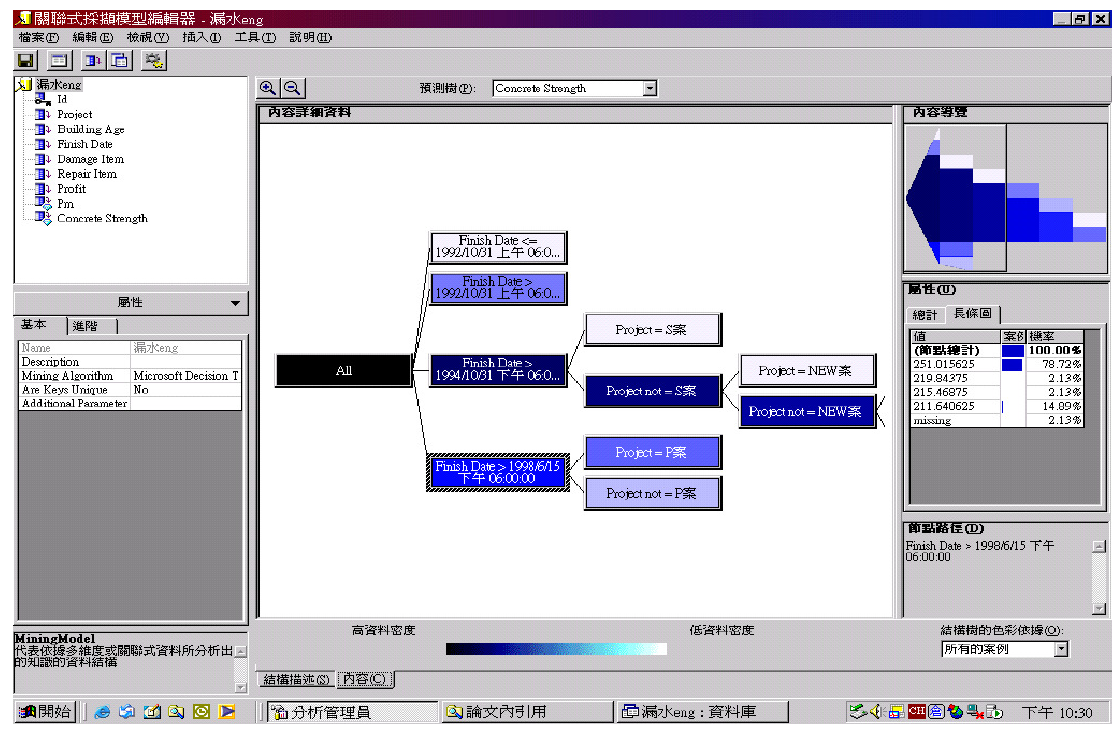
Fig. 2. Usage of average concrete strength for decision tree analysis